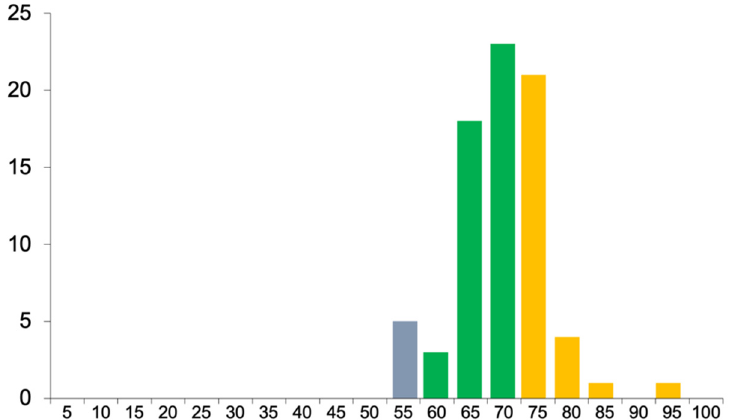
Figure 1. Distribution of final examination marks.